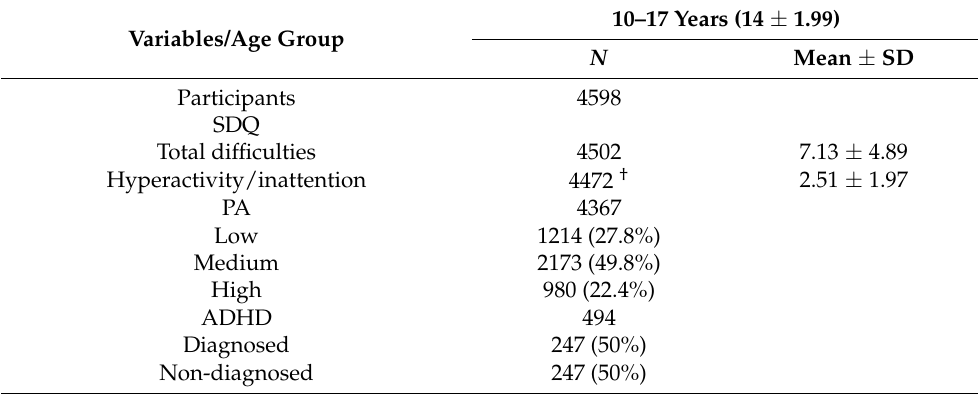
Table 3. Descriptive characteristics of the study population at wave